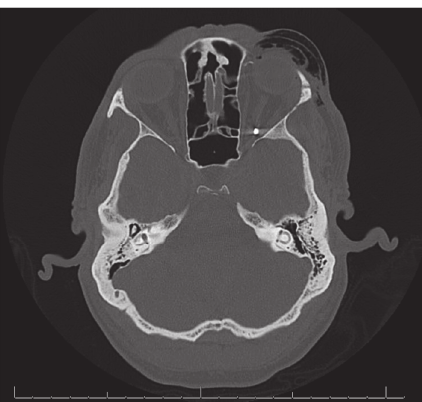
Figure 1: A representative axial head computed tomography image demonstrating an intraorbital metallic foreign body adjacent to the left optic nerve.